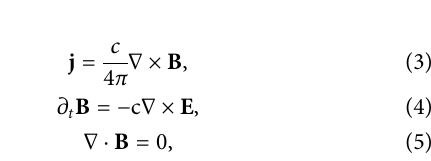
Frontiers in Physics |